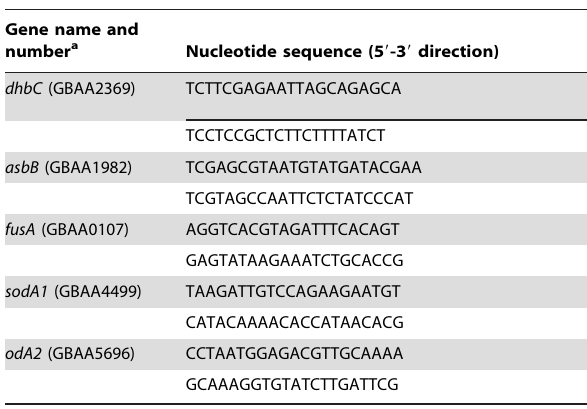
Table 6. Oligonucleotide primers used in this study.